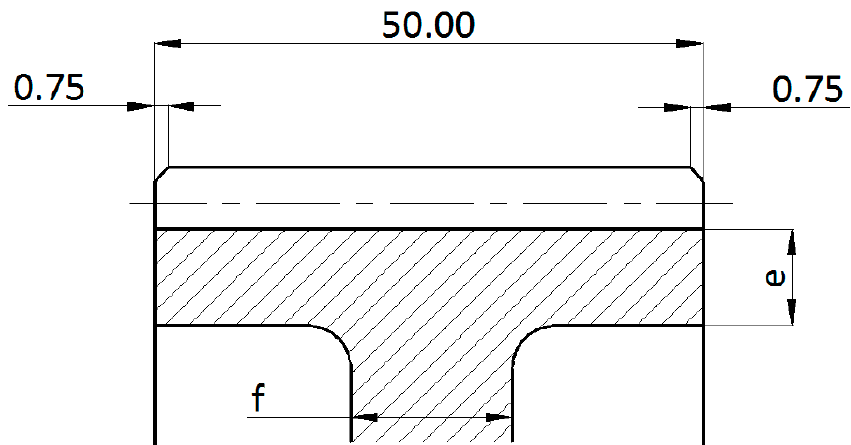
Figure 5. Active gear width during engagement of the wheels.